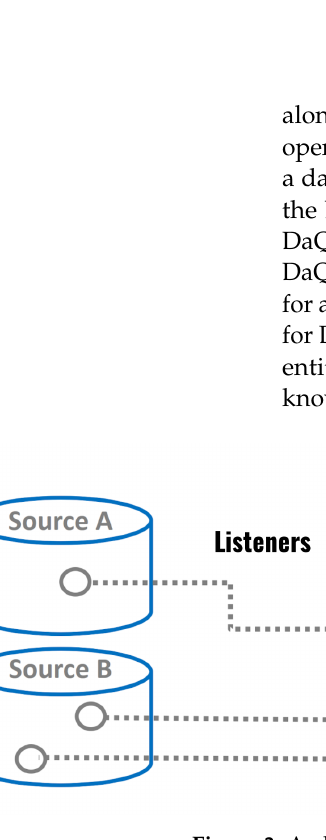
Figure 3. Architecture of Data Quality Library (DaQL) to Monitor Data Quality